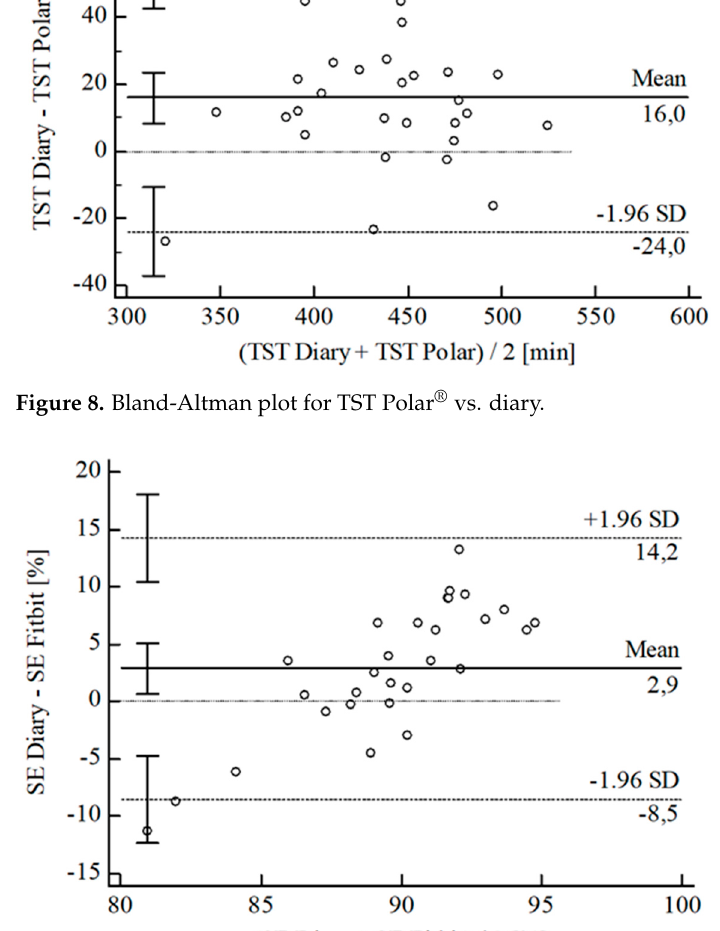
Figure 9. Bland-Altman plot for SE Fitbit ® vs. diary.